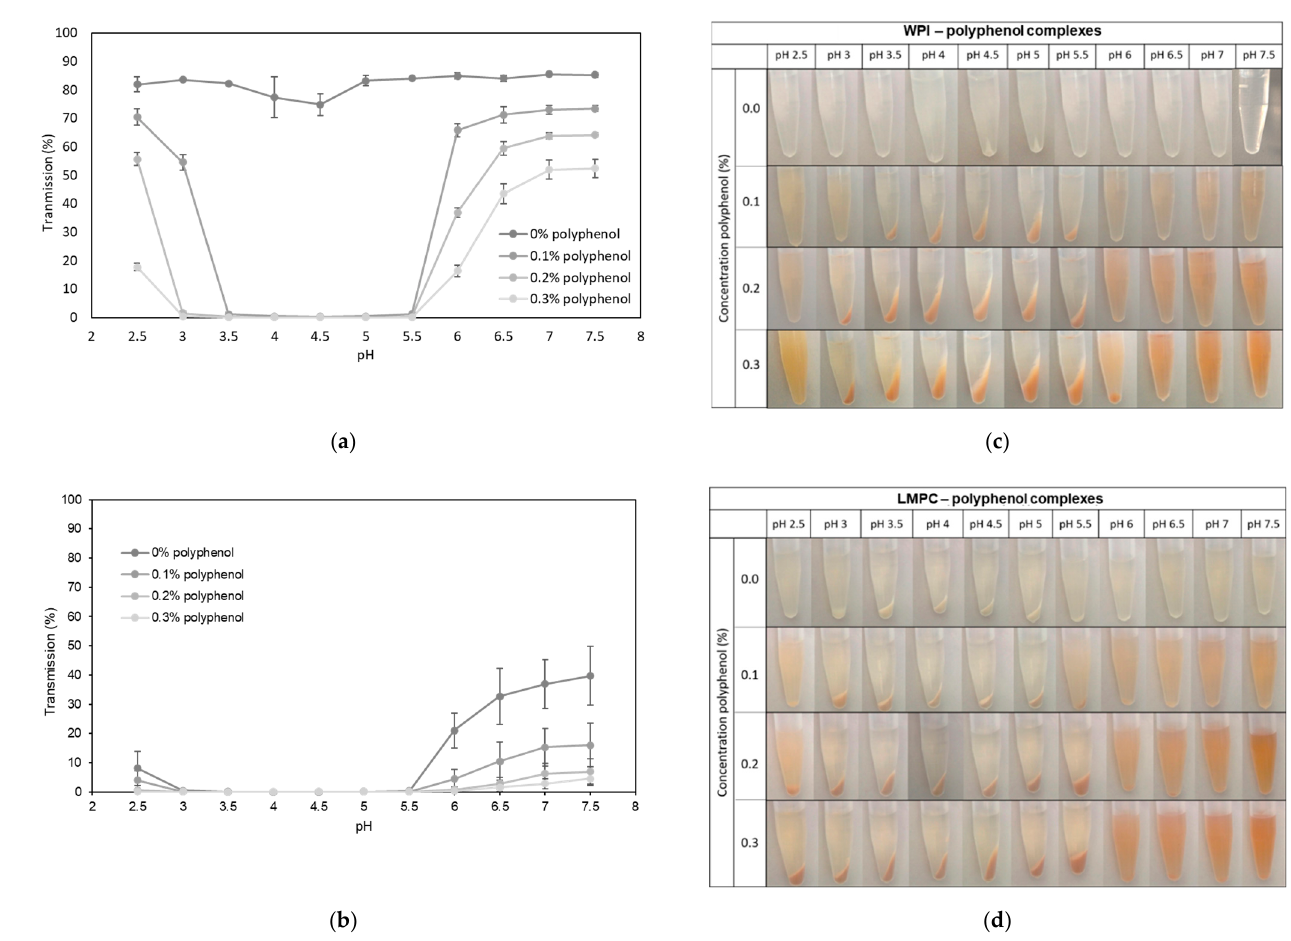
Figure 5. Transmission of ( a ) WPI and ( b ) LMPC solutions with polyphenol concentrations at 0, 0.1, 0.2, and 0.3% versus pH range of 2.5 to 7.5, with attached visual observation of sediments after centrifugation ( c ) and ( d ).